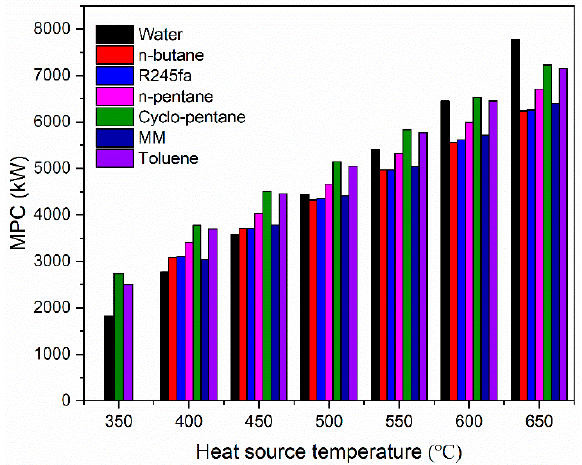
Figure 15. The MPCs of SRC and ORC systems.